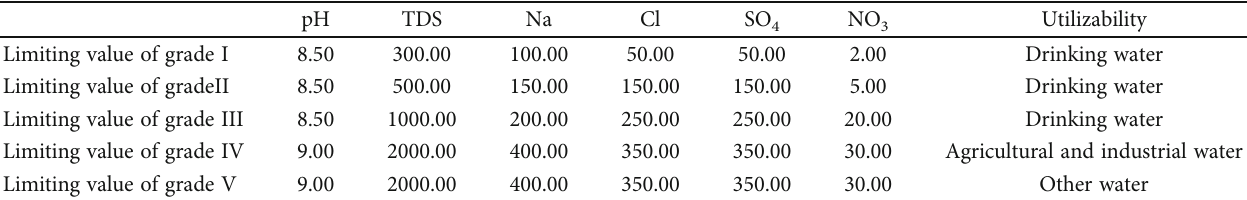
Table 2: The limiting value of each grade І from Groundwater Quality Standard